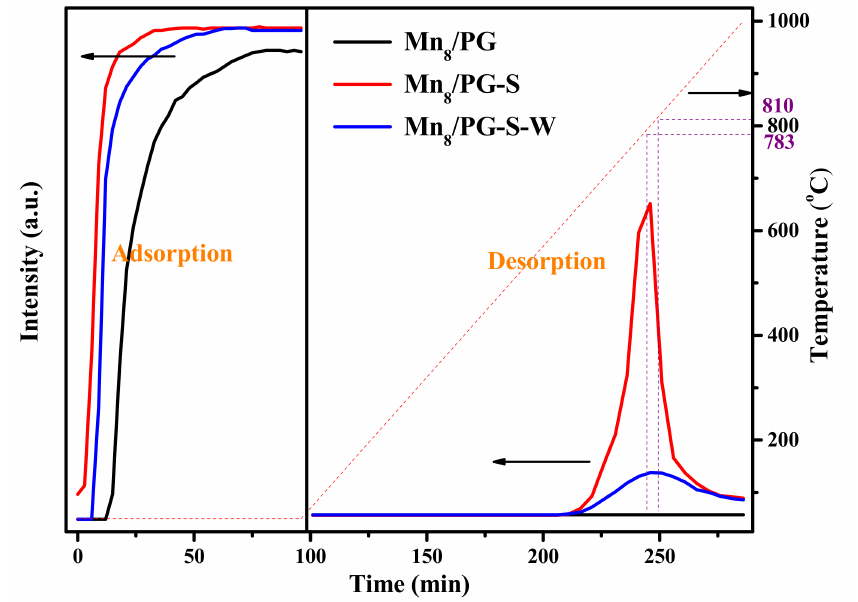
Figure 9. The SO 2 emission profiles of isothermal adsorption and following temperature- programmed desorption (TPD). Reaction conditions: 0.5 g of the catalyst, 400 ppm of SO 2 , GHSV = 16,000 h − 1